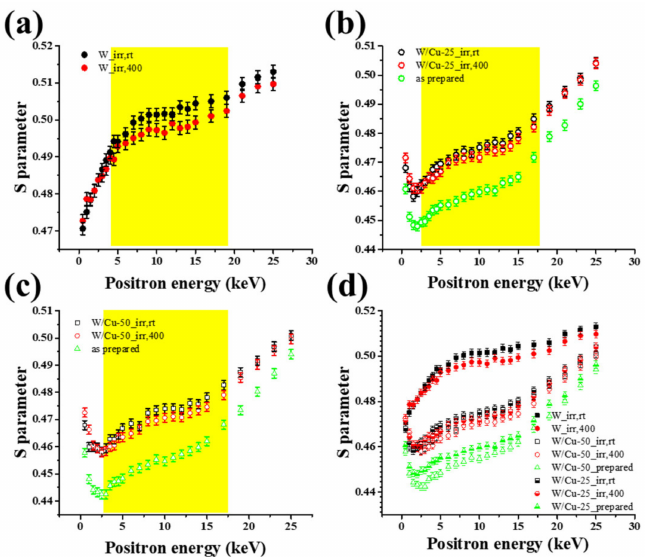
Figure 4. The S–E curves of: ( a ) W monolayer; ( b ) W/Cu-50 nanocomposite; ( c ) W/Cu-25 nanocom- posite, with He + irradiation at RT and 400 ◦ C; ( d ) the comparison of the S parameters of the W monolayer, W/Cu-50, and